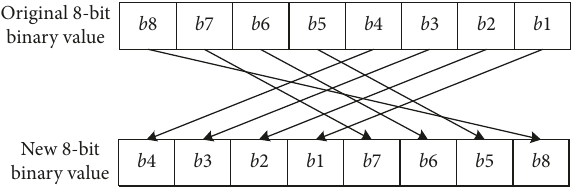
Figure 3: The process diagram of the bit-plain scrambling